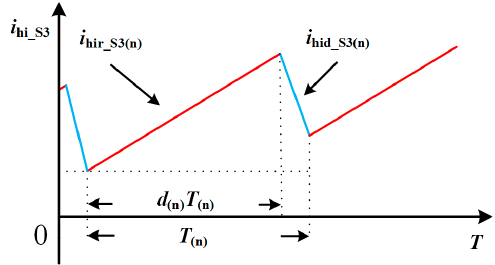
Figure 3. The D-S current of the high side MOSFET S 3 .